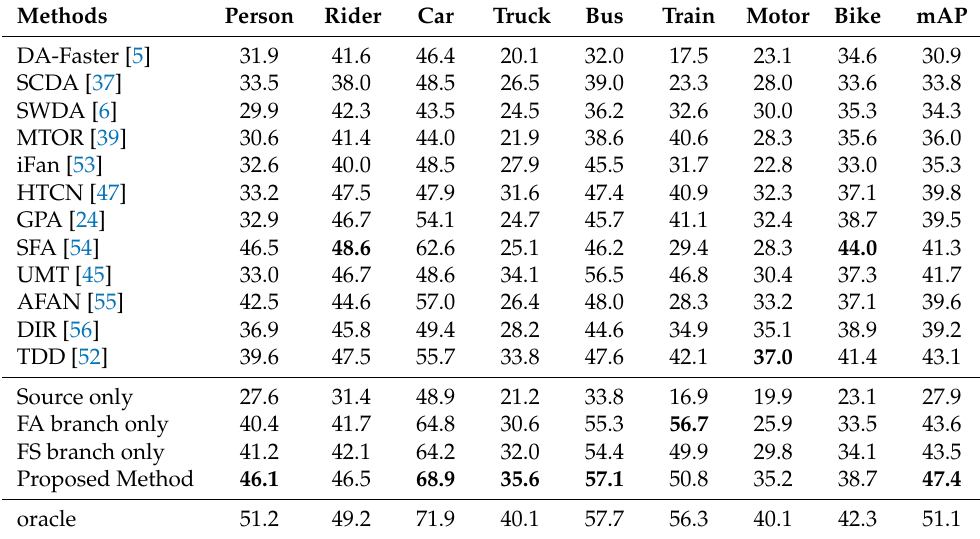
Table 5. The mean Average Precision (mAP) of different models on Foggy Cityscapes val set for Cityscapes → Foggy Cityscapes transfer. The best results are in